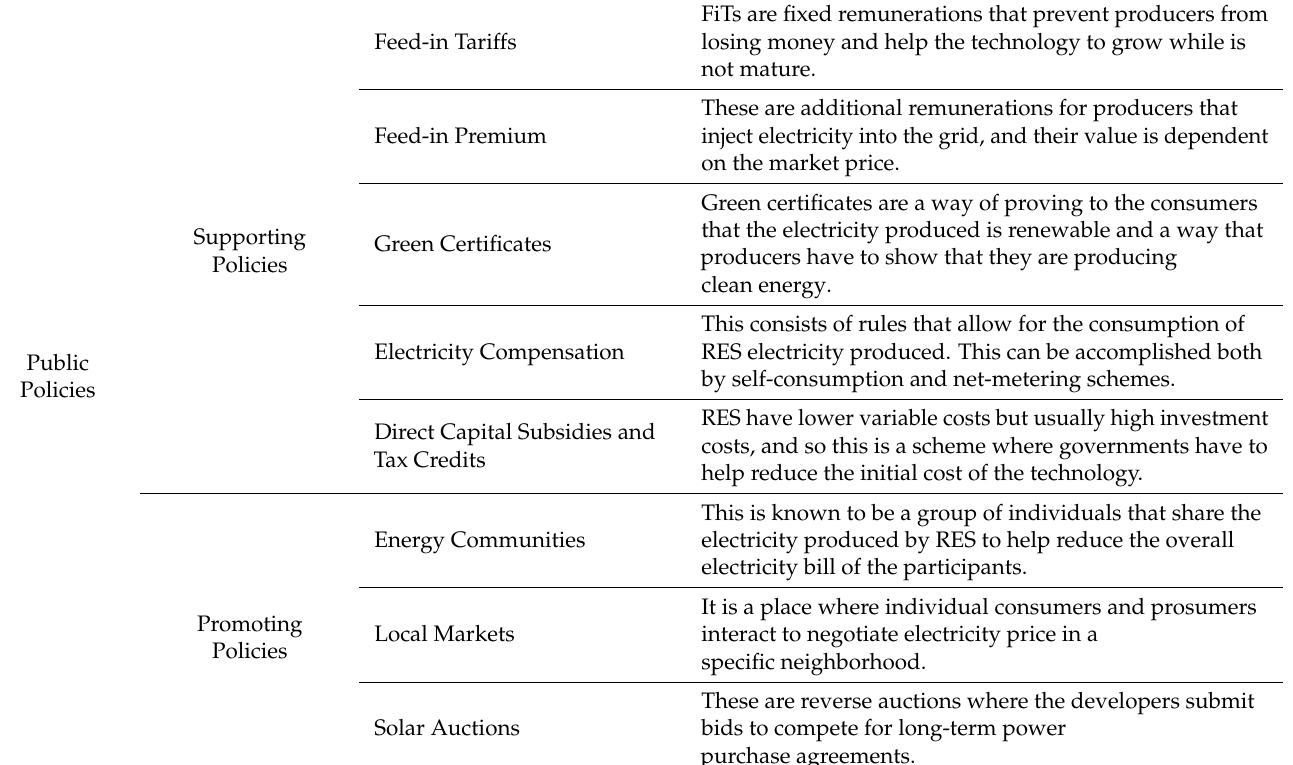
Table 3 sums up the past and present policies: Table 3. Summary of the public policies described in the present